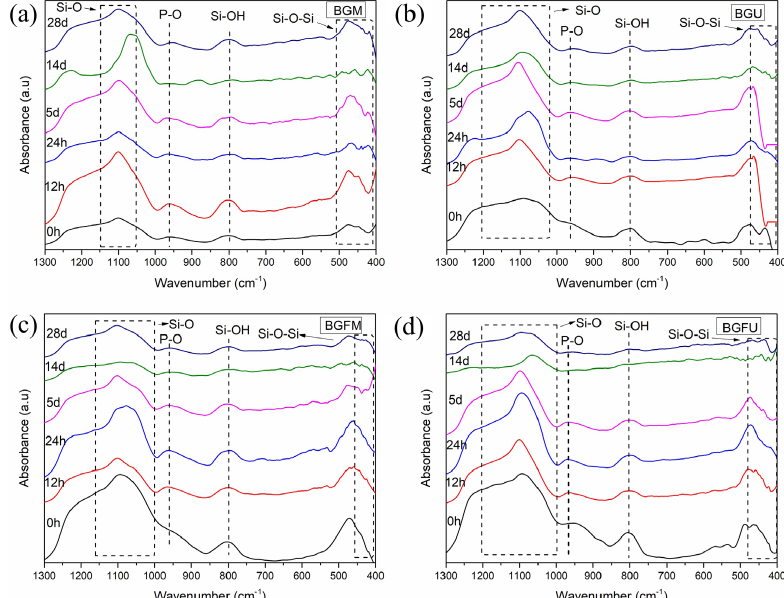
Figure 9. FTIR spectra of the surfaces of the (a) BGM, (b) BGU, (c) BGFM and (d) BGFU after incubation in SBF for 12 h, 24 h, 5 d, 14 d and 28